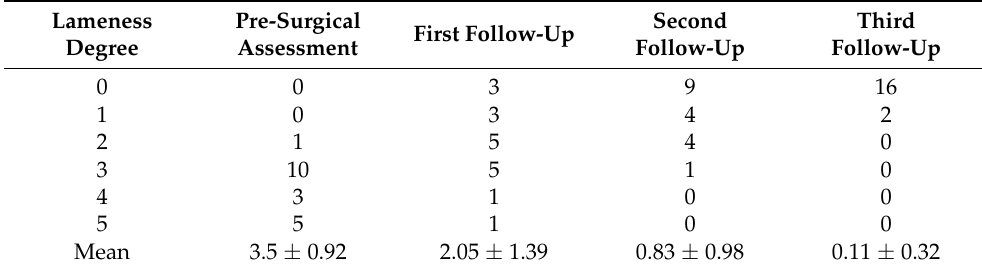
Table 4. Number of patient per follow-up for lameness degree